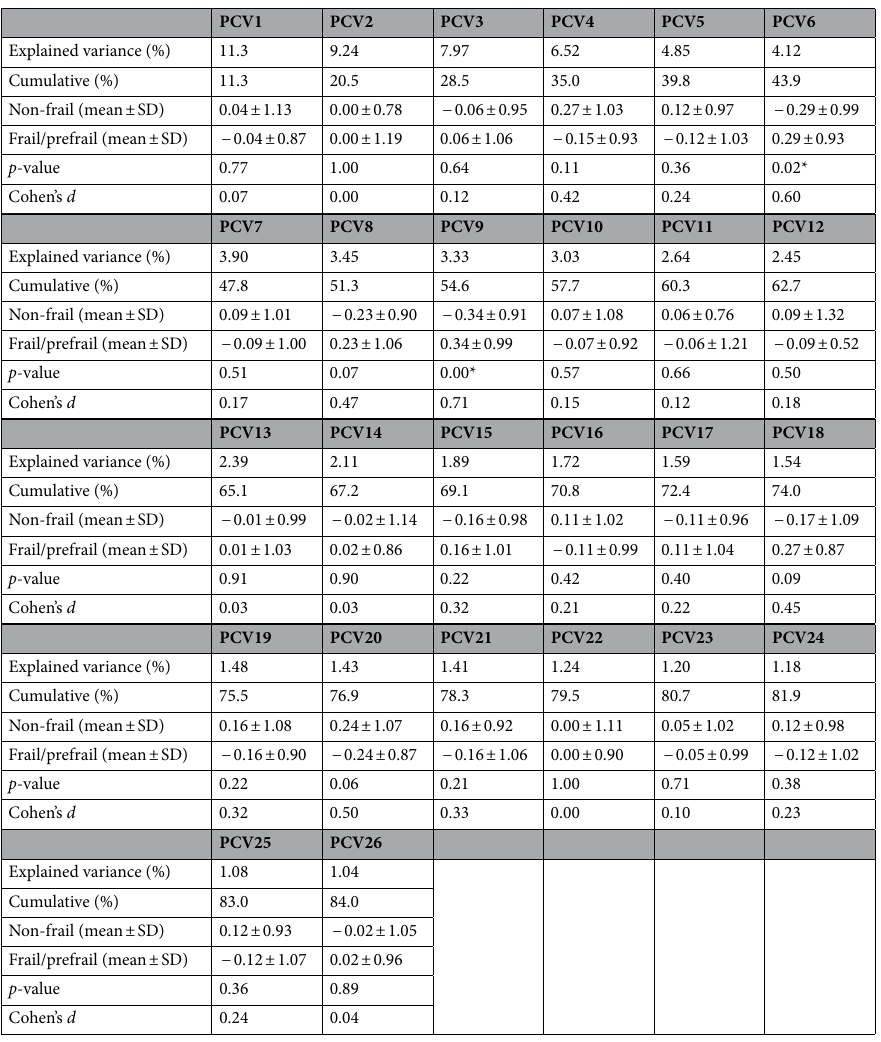
Table 2. Results of main principal component analysis. Principal component analysis was applied to the correlation matrix of 1224 variables (i.e., intra-participant mean and standard deviation for 51 time points, four angles in three axes) calculated from the 60 data sets (each leg of 30 participants). PCV principal component vector. The “*” symbol indicates significant differences between the non-frail and frail/prefrail groups (* p <